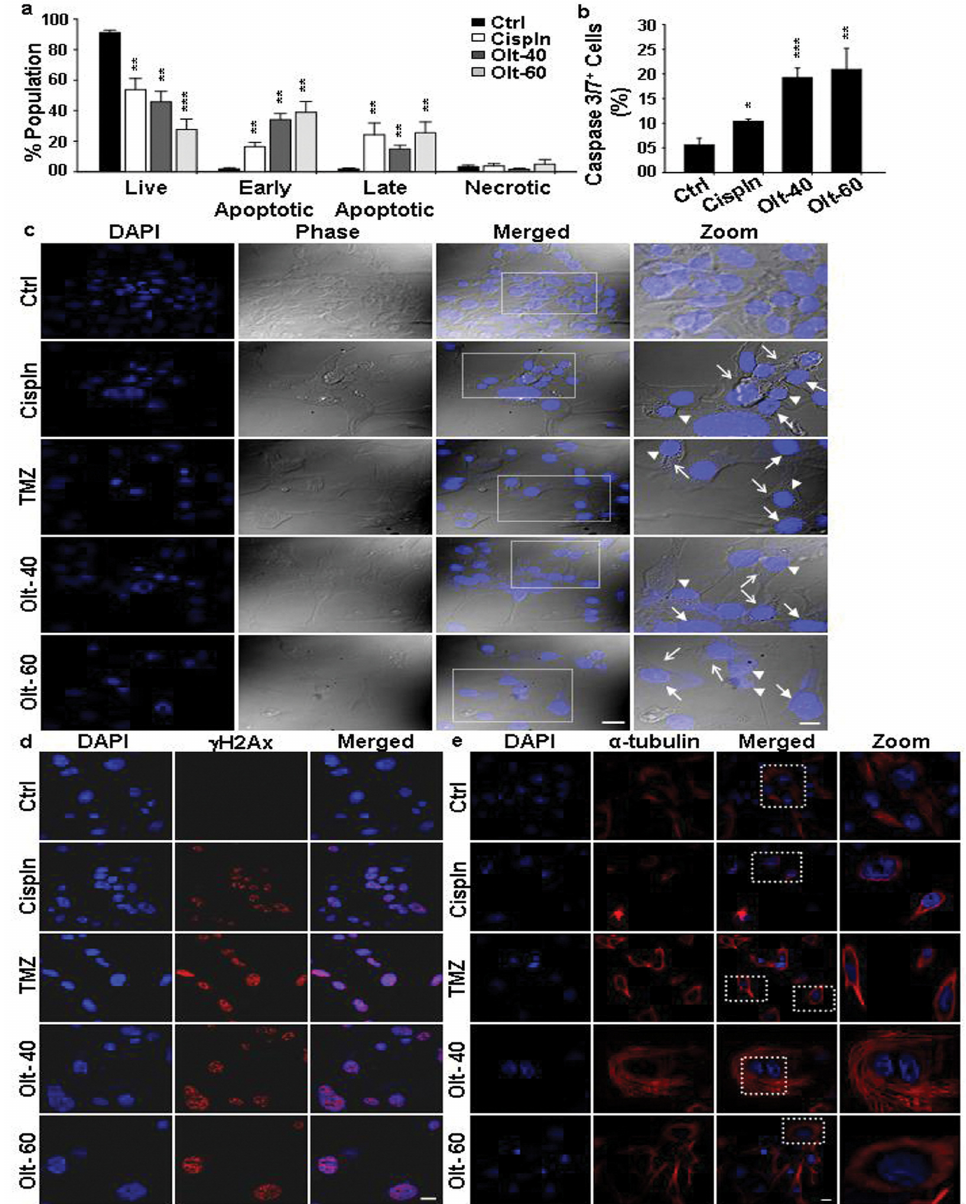
Figure 2. Pro-apoptotic influence of Olt on U-87 MG cells: ( a , b ) Flow cytometry quantification of ( a ) Annexin V/APC–PI and ( b ) Caspase 3/7 stained population indicates an increase in both early (Annexin V + /PI - ) and late (Annexin V + /PI + } apoptotic cells and Caspase 3/7 + cells following Olt exposure of U-87 MG cells for 48 h. Cells treated with Cispln served as the positive control for the treatment group. Data are presented as mean ± SEM (n = 3–7). * p ≤ 0.05; ** p ≤ 0.01; *** p ≤ 0.001 compared to the untreated Ctrl. ( c ) Hoechst 33342 staining reveals chromatin condensation (arrowhead), nuclear fragmentation (closed arrow), and membrane blebbing (open arrow) seen in U-87 MG cells treated with TMZ, Cispln (both positive controls), and Olt (40-, and 60 μ M) for 48 h. Magnified views (Zoom) of the boxed regions are shown with contrast adjustment for better visualization. ( d ) γ H2 α X staining of U-87 MG cells displaying punctate nuclei in the treated groups reflects nuclear fragmentation upon exposure of Cispln, TMZ, and the Olt for 48 h. ( e ) Microtubules’ rearrangement was detected by α -tubulin staining in 48 h post-treated (Cispln, TMZ, Olt) U-87 MG cells. Magnified views (Zoom) of the boxed regions are shown for better visualization. Scale bar: 20 µ M ( c – e ), 10 µ M (zoomed images in c , e